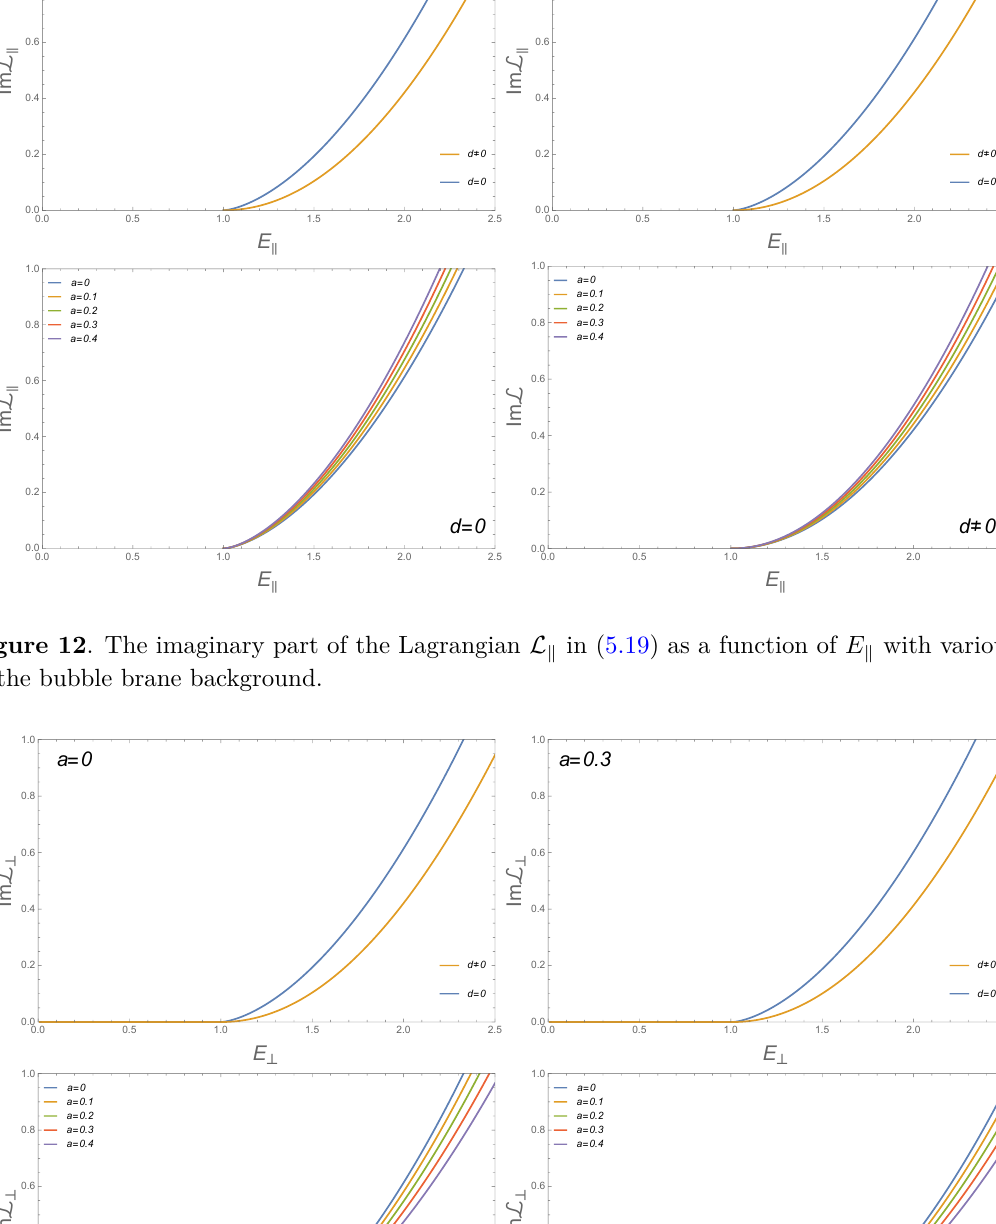
Figure 13 . The imaginary part of the Lagrangian L ⊥ in (5.19) as a function of E ⊥ with various a in the bubble brane